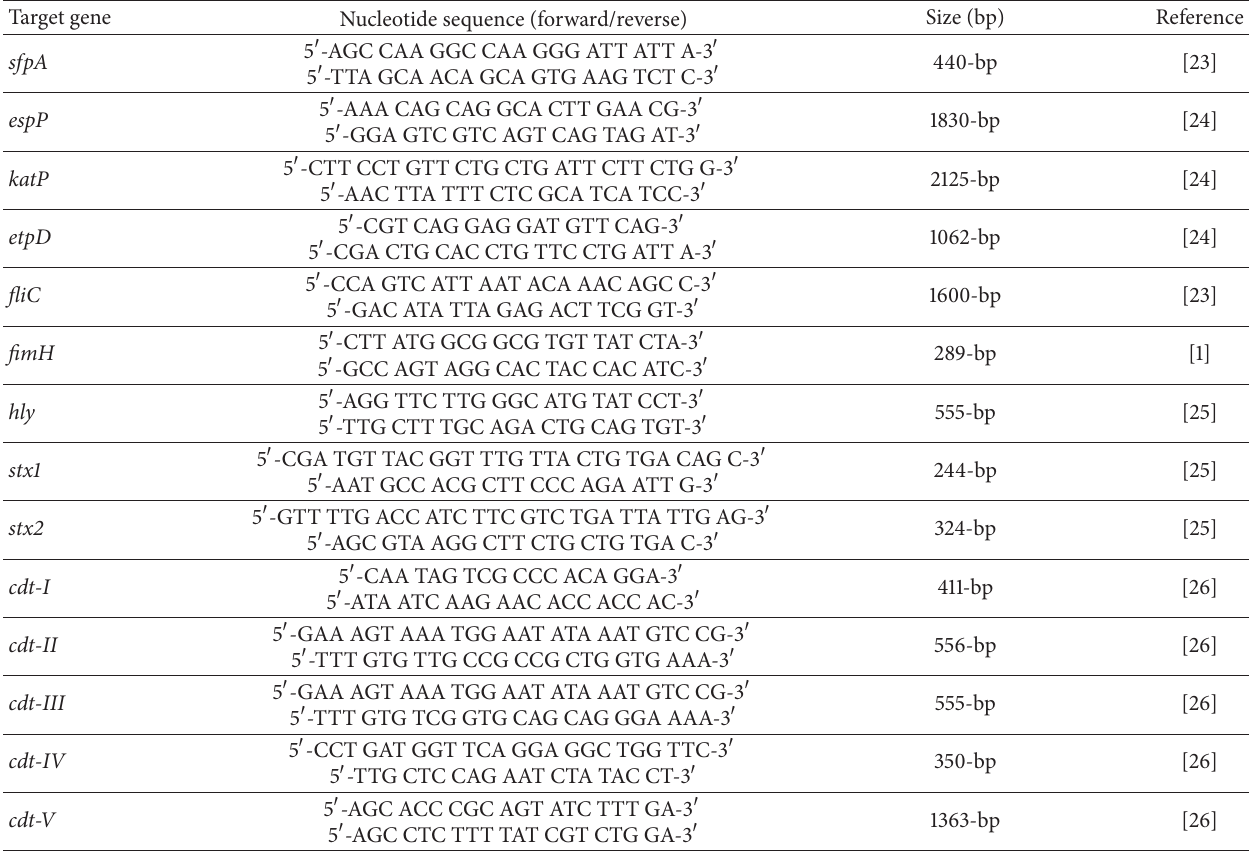
Table 1: Nucleotide sequence of primers for amplification of target